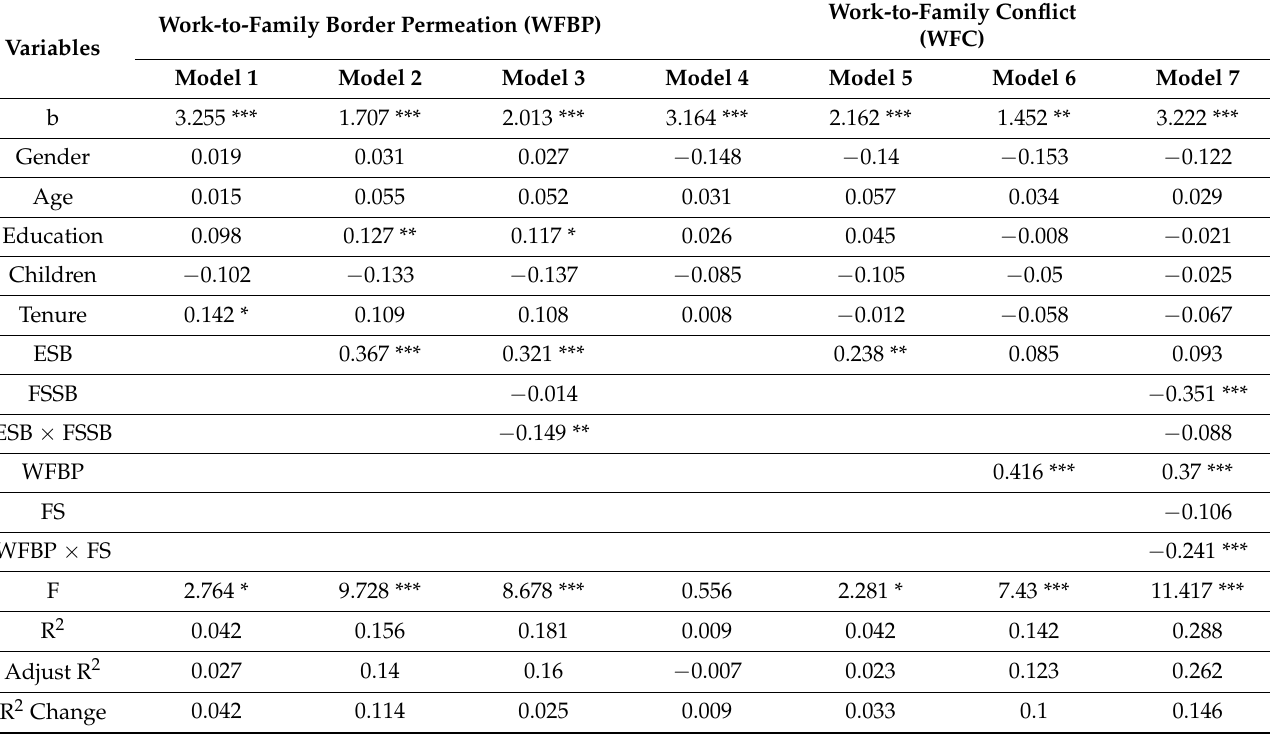
Table 3. Moderating effect of FSSB and family